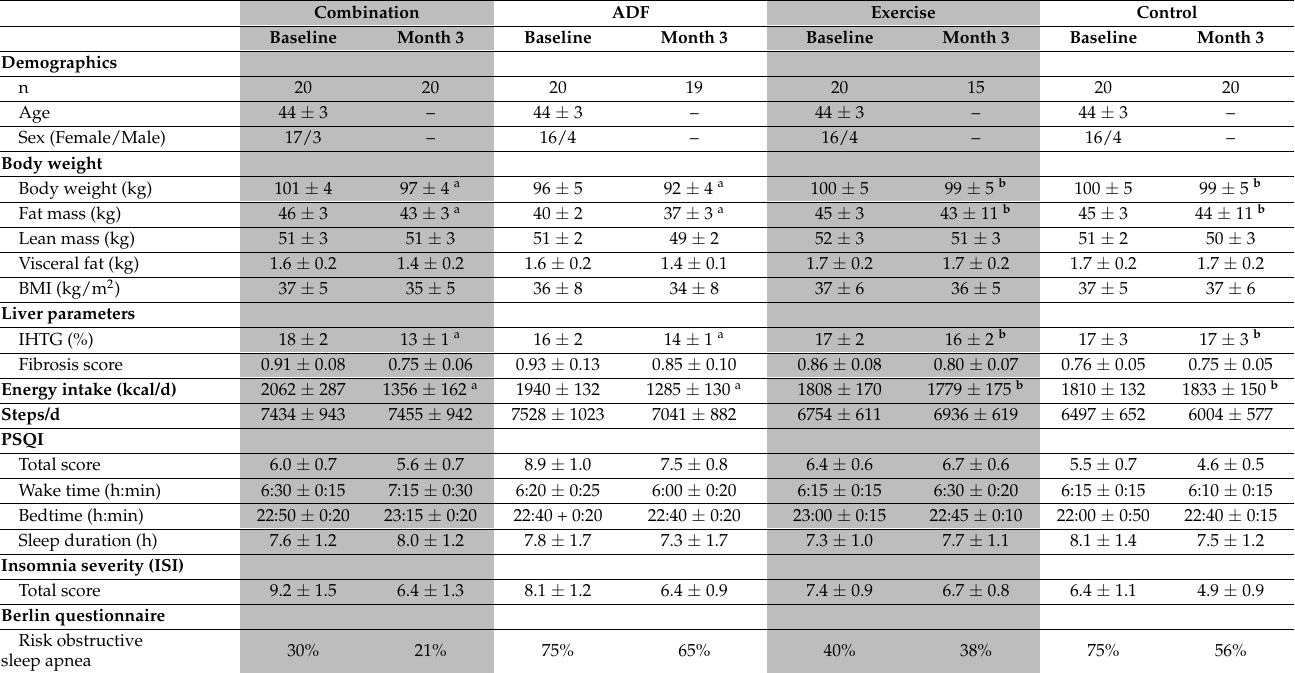
Table 1. Body weight, body composition, and sleep variables after 3 months of intervention.